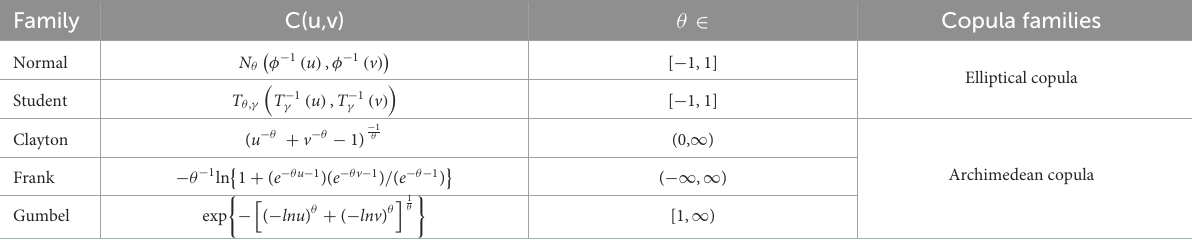
TABLE 2 The first five families of copulas. Family Copula families Normal